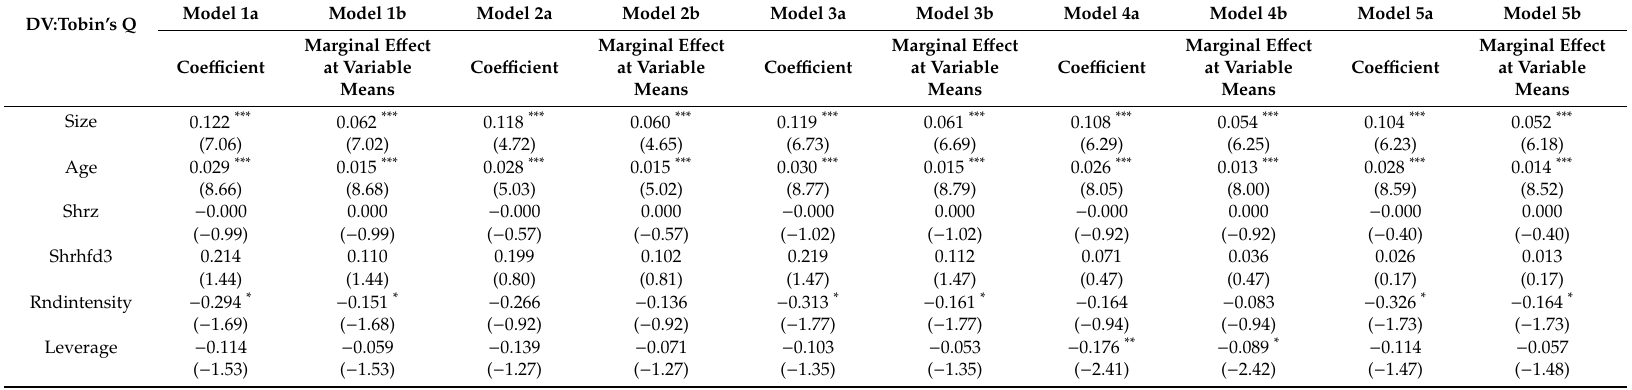
Table 2. GEE estimations of the antecedents of technological